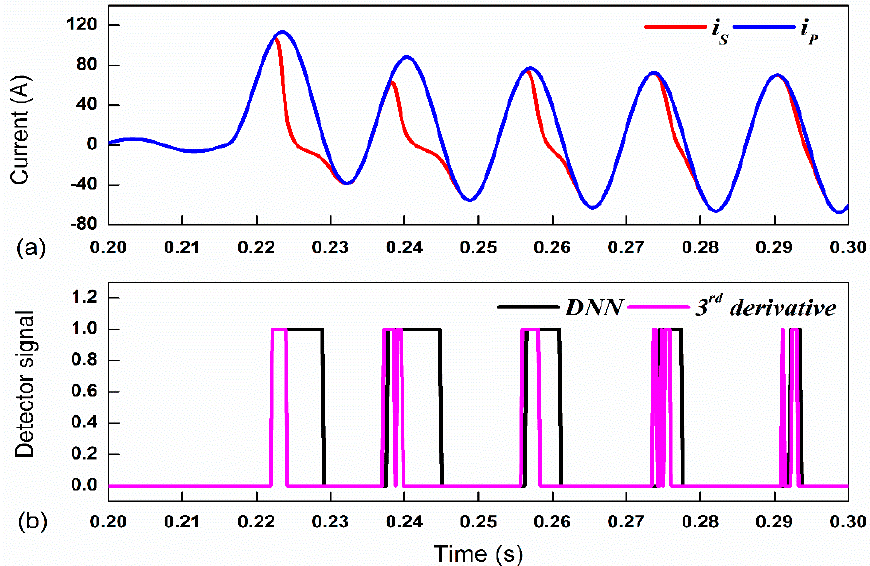
Figure 8. The detection result of CT saturation on the 154-kV (FIA of 0 0 , and remnant flux of 80%) . ( a ) Saturated and non-saturated waveform; ( b )Detection signals. ( a ) Saturated and non-saturated waveform; ( b )Detection